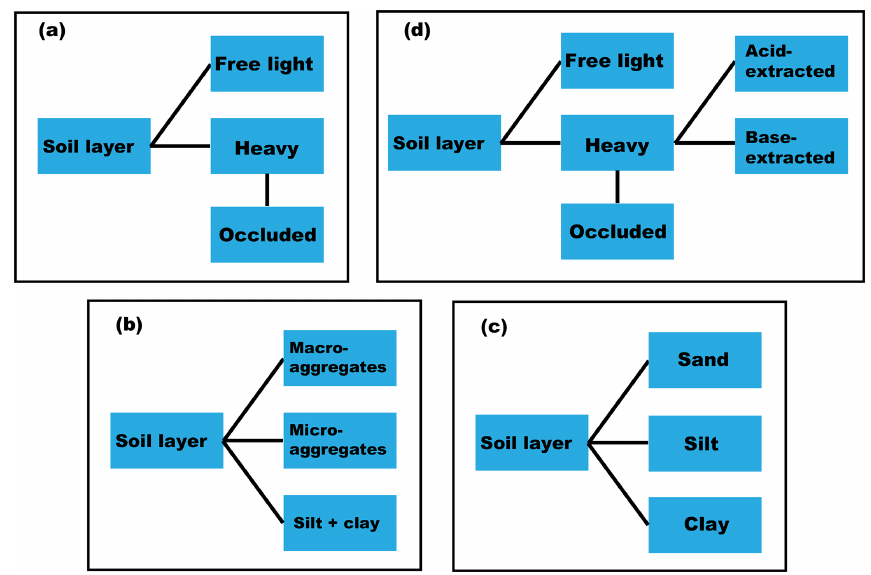
Figure 3. One key feature of the ISRaD structure is the ability to classify and categorize data generated from diverse methods for fractionating soils. The ISRaD approach requires specification of the fractionation scheme applied, which may include, but is not limited to, density (a) , aggregate (b) , and/or particle size (c) separations. In each of these examples, the fraction data are linked to a specific soil layer. Classification of the fractionation scheme, along with several other fields that specify the nature of the fractionation method, allows for an accurate partitioning of mass between the individual fractions such that the total mass of the soil layer can be reconstructed. A proper accounting of mass attributable to each soil fraction, which in some cases may be derived from more complicated multistep or sequential fractionations (d) , is essential in order to compare measurements across these diverse